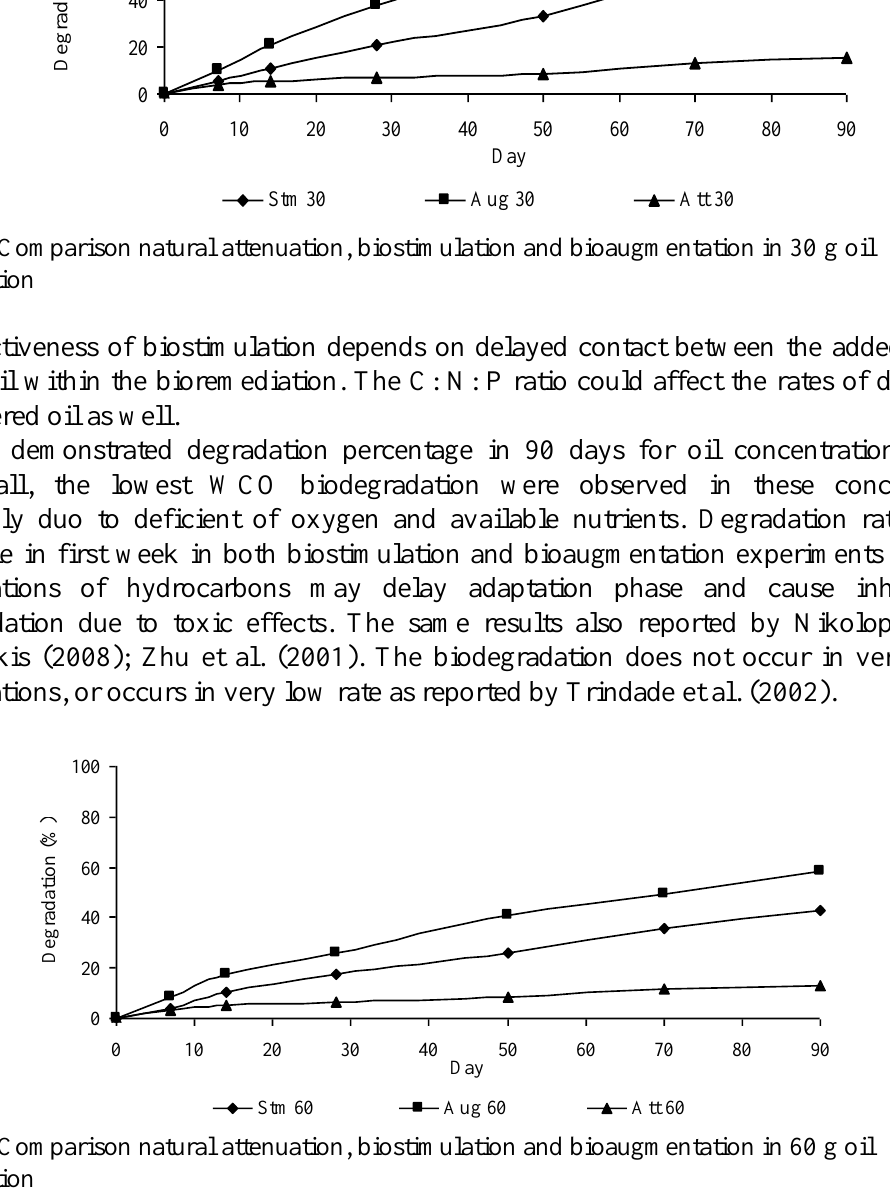
Figure 3. Comparison natural attenuation, biostimulation and bioaugmentation in 60 g oil